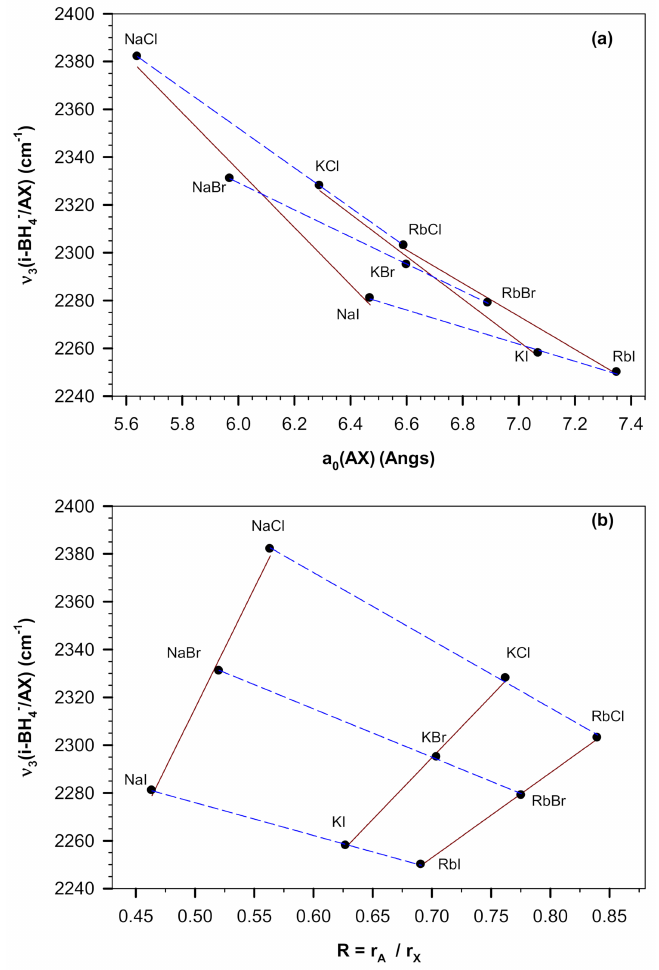
Figure 4. Graphical representation of ν 3 (i − BH 4 − ) as a function of ( a ) the cell parameter a 0 and ( b ) the radius ratio (R = r A /r X ) of the corresponding AX halide. Red solid lines represent common cations (A-series) and blue dashed lines are for the common anion